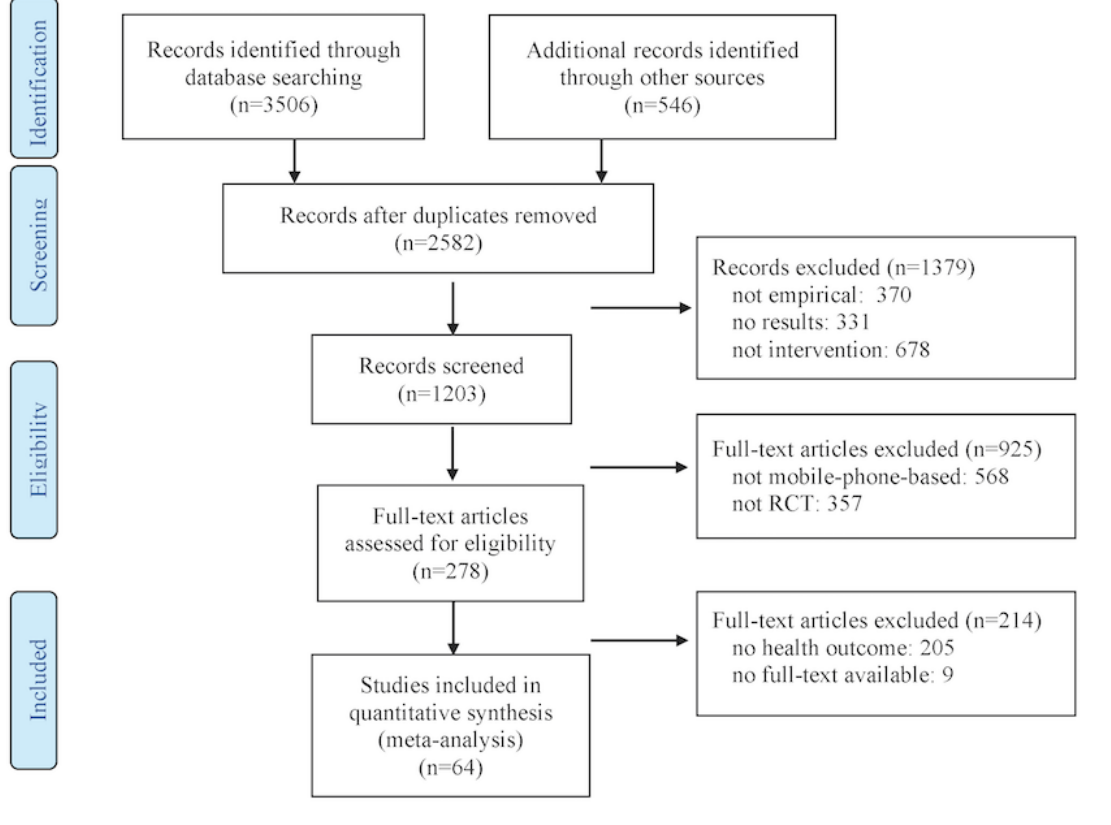
Figure 1. Summary of selection process used in this study. Interventions using mobile phones only for data collection or making phone calls were excluded in this meta-analysis. RCT: randomized controlled